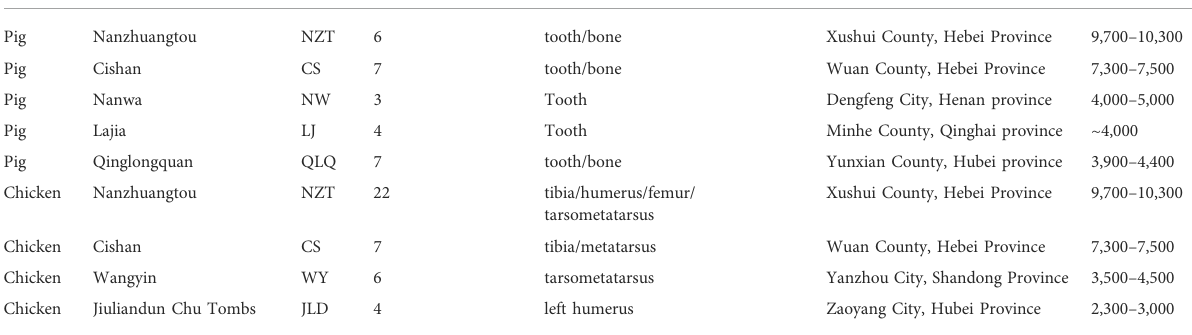
TABLE 1 Ancient sample information. Species Archaeological sites Label Sample number Sample